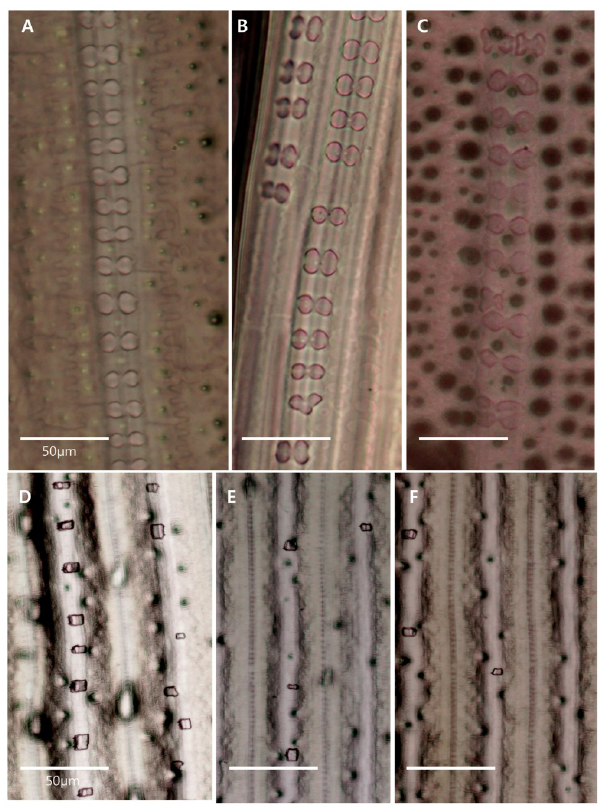
Fig 5. Optical microscopic images of leaves and motor cells (400 × magnification, upper; 100 × , lower). (A, D) wild- type. (B, E) RNAi plant. (C, F) dr mutant. Bars = 50 μ m.